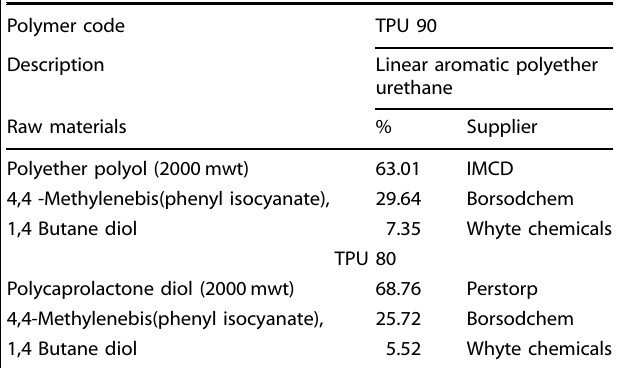
Table 1. Compositional data of thermoplastic polyurethanes Polymer